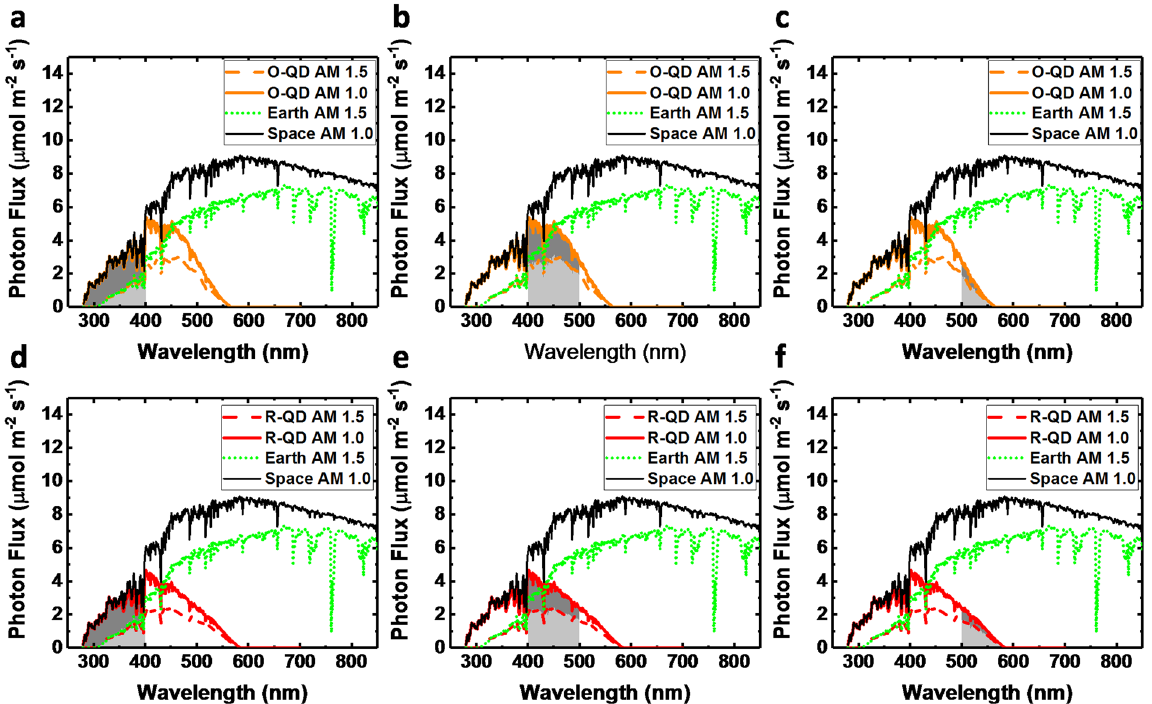
Fig. 4 Comparison between absorbed photon fl ux for QD fi lms under AM 1.0 and AM 1.5 spectra. Convoluted absorption spectra of the O-QD fi lm with the AM 1.0 and AM 1.5 spectra are presented in ( a – c ), where the integrated areas of absorbed photon fl ux of the ( a ) UV (<400nm), ( b ) blue (400 – 500nm), and ( c ) green (500 – 600nm) spectral ranges are calculated for each solar spectra and compared. Similarly, convoluted absorption spectra of the R-QD fi lm with the AM 1.0 and AM 1.5 spectra are presented in ( d – f ), where the integrated areas of absorbed photon fl ux for the ( d ) UV, ( e ) blue, and ( f ) green spectral ranges are calculated for each solar spectrum and compared. Table 3 Estimated changes in PPFD due to absorption and emission of QD fi lms for AM 1.0 and AM 1.5 solar